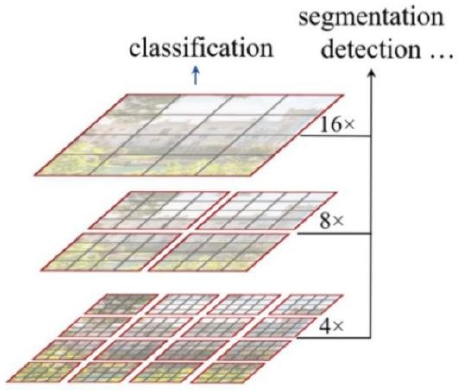
Figure 7. The hierarchical feature map constructed by the Swin Transformer.